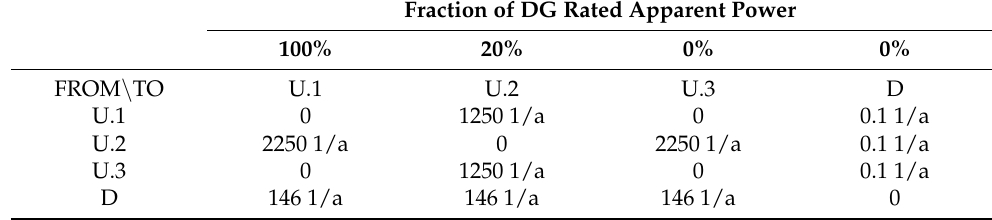
Table 6. Reliability parameters of PVPP